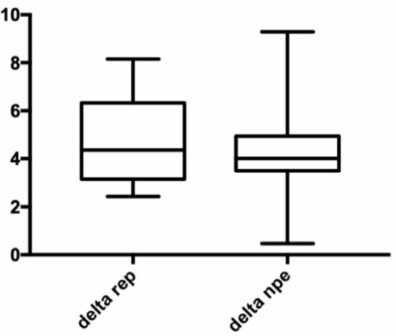
Figure 4. Anterior width. Delta REP is the variation in patients treated with RPE; Delta NPE-2 is the variation in patients treated with NPE-2; the numbers show the variation measured in